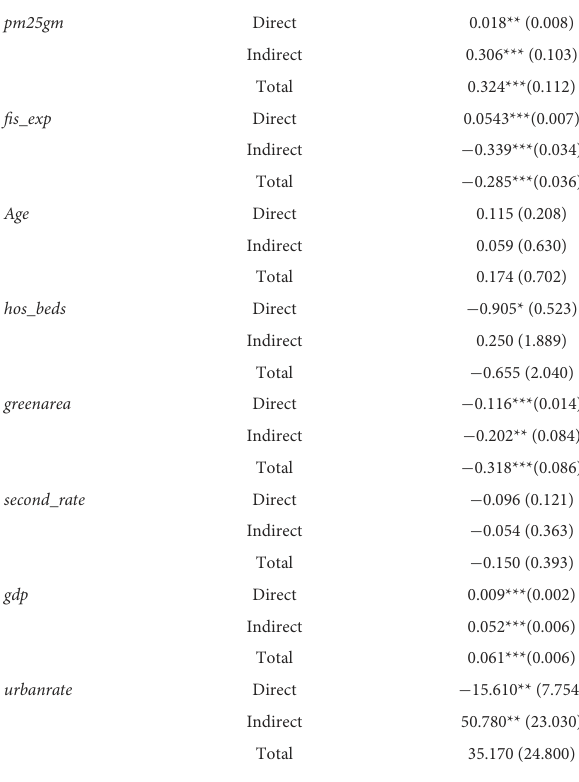
TABLE 11 Direct, indirect, and total